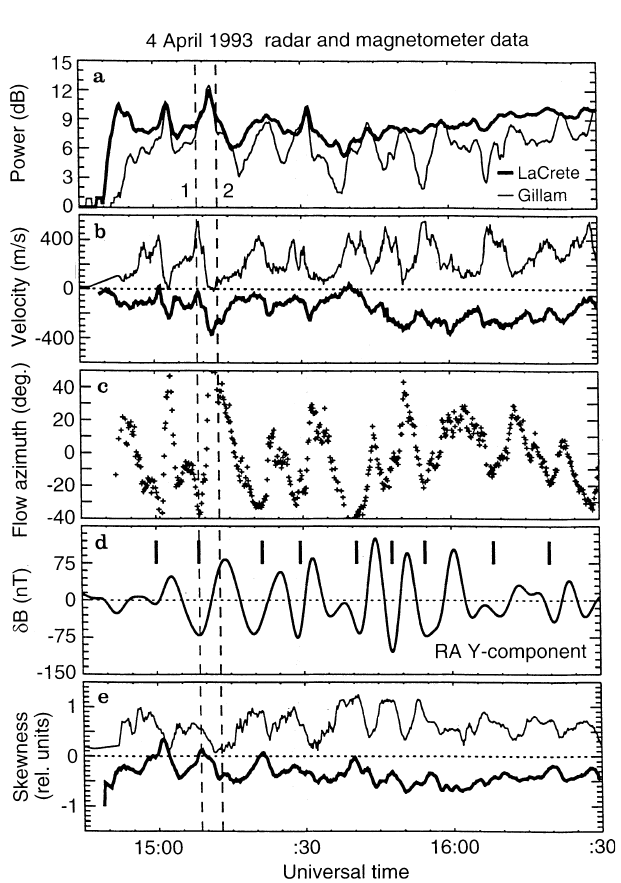
Fig. 4a–e. Temporal behaviour of the power a , mean Doppler velocity b and skewness e on the Gillam-Saskatoon ( thin line ) and LaCrete-Saskatoon ( thick line ) radio links during the period of pulsations. c Shows flow azimuth (CCW from the east) inferred from the G-S and L-S Doppler velocities. d Shows the rectified Y-compo- nent (east-west) of the Rabbit